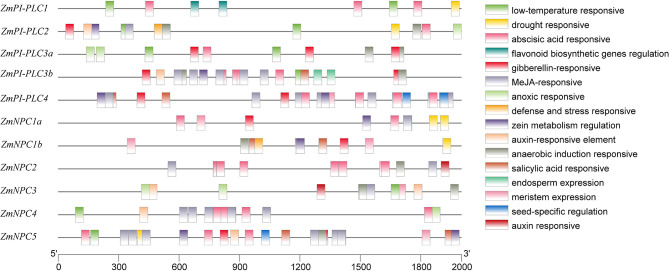
Putative regulatory cis-elements in ZmPLC family gene promoters. Different cis-elements are represented with different color box.